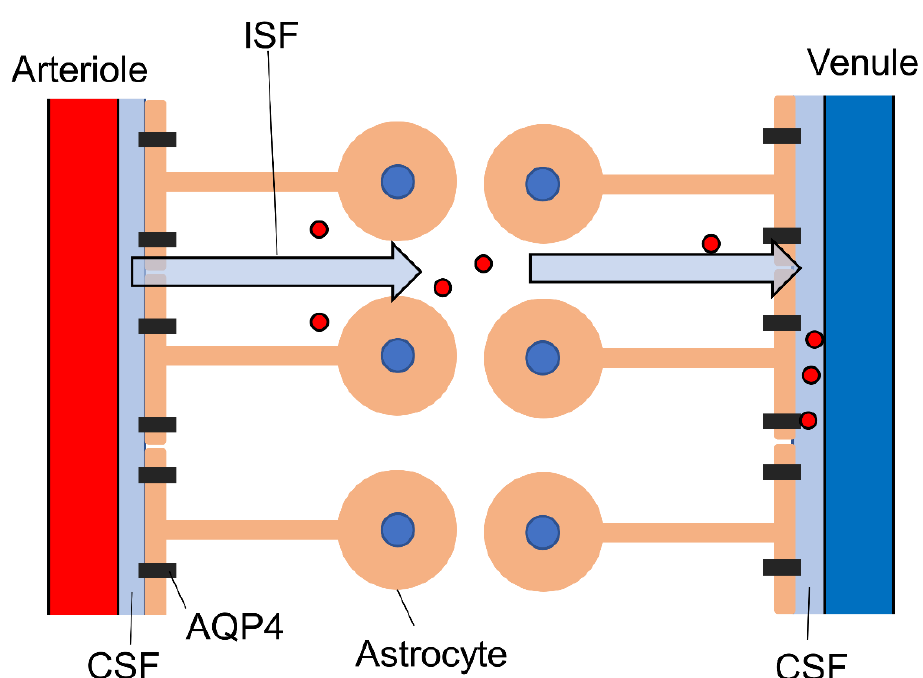
Figure 2. Schematic diagram of the glymphatic system. Astrocyte endfeet regulate the influx and efflux of CSF through aquaporin-4. This interstitial flow contributes to the clearance of waste, including amyloid-β and tau protein (red circles). AQP4, aquaporin-4; CSF, cerebrospinal fluid.